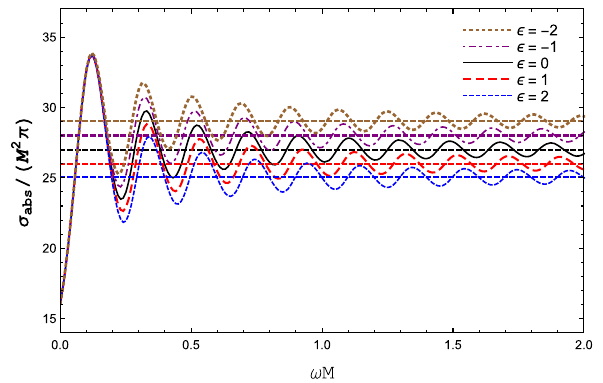
Fig. 12 Total absorption cross section of Schwarzschild-like objects for different values of ε . The horizontal dashed lines represent the geo- metrical absorption cross sections in each case